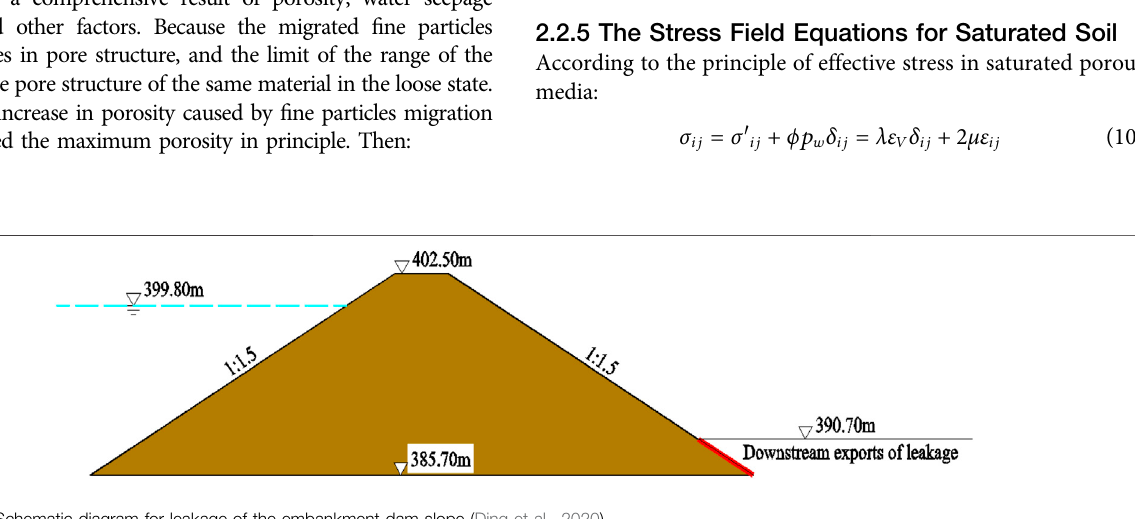
Frontiers in Earth Science |